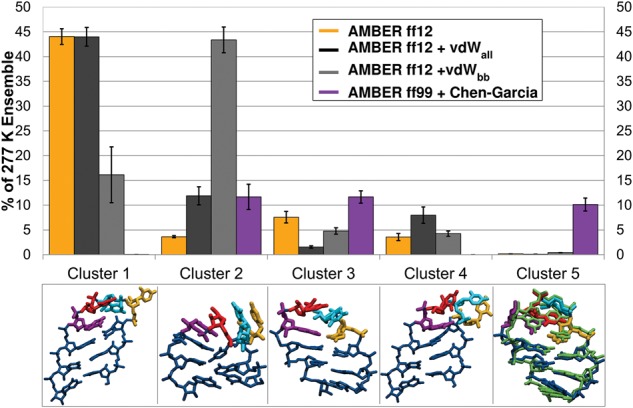
Combined clustering results for UUCG tetraloop simulations. Cluster number is shown on the x-axis and percentage of each simulation's 277 K ensemble is shown on the y-axis. Representative structures are shown below the bar graph. The native structure found in cluster 5 is shown overlapped with the NMR structure (in green).